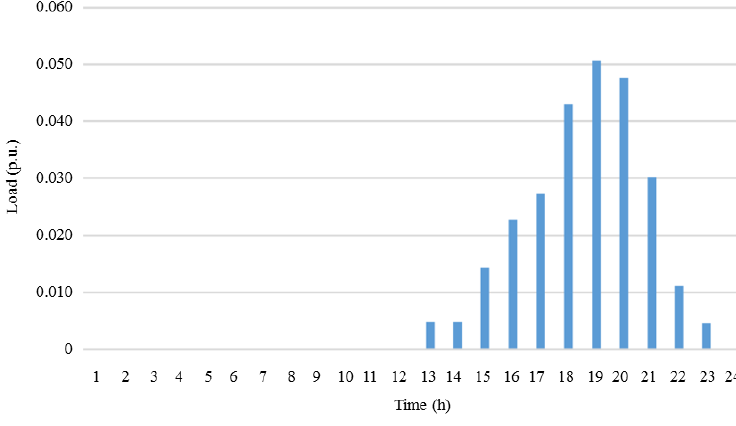
Figure 12. Load demand profile for Case 4 (50 EVs, uncontrolled charging).